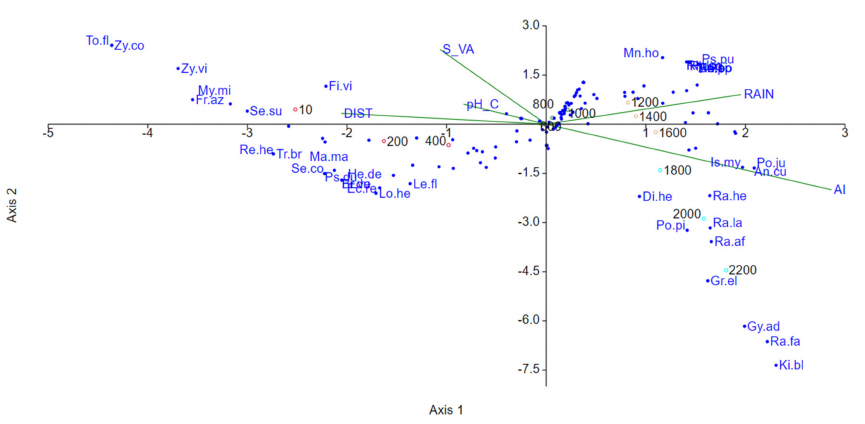
Figure 7. Ordination diagram showing the result of the canonical correspondence analysis (CCA) of the 141 bryophyte species (blue dots) along the first two axes, the 12 sites (open circles) and their corre- lation with 5 explanatory variables (green segments). The segments show the direction of maximum variation in the ecological variables; longer segments indicate stronger correlations between variables and axes. The directions and lengths of the segments show the degree of correlation between species composition and the explanatory variables. The names of the species with the highest contribution to the model (38 species of the fourth quartile) are indicated by their abbreviations (Appendix A). Explanatory variables included the elevation (ALTI), disturbance index (DIST), bark pH (pH_C); mean annual precipitation (RAIN); and richness of vascular plants